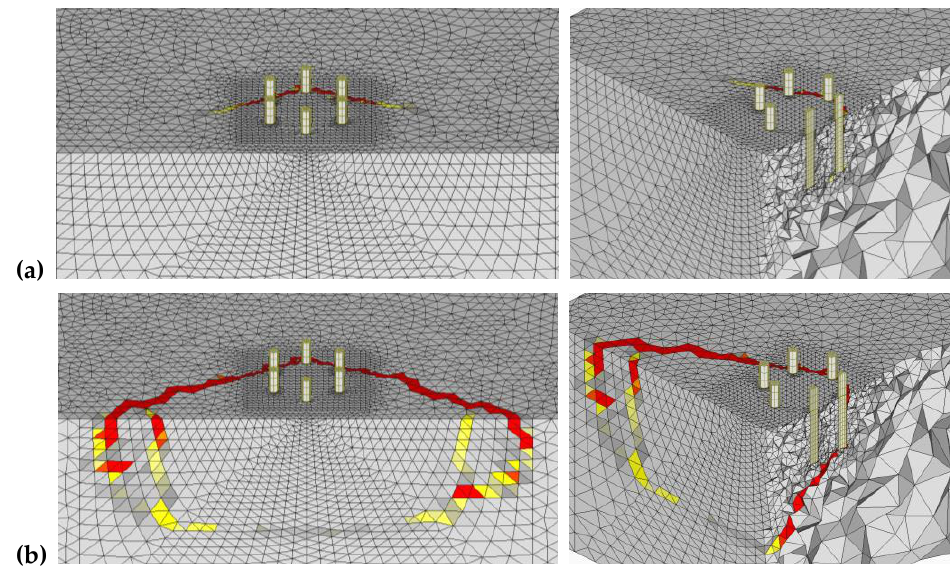
Figure 14. Crack pattern obtained from numerical analysis for Group Hex-B ( a ) at peak load, and ( b ) Crack pattern in the post-peak phase.